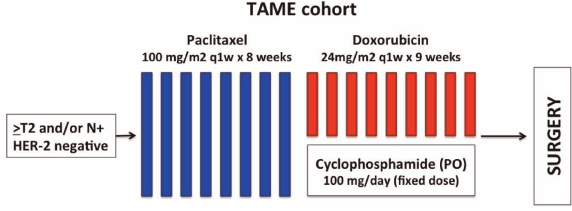
Figure 2. TAME cohort study